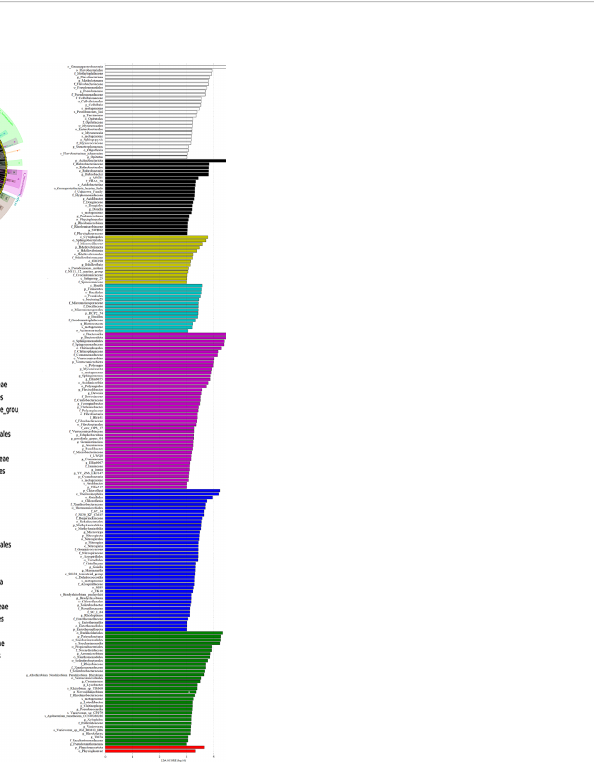
FIGURE 4 LEfSe analysis of soil bacterial community structure at different taxonomic levels among different rotation systems (LDA ≥ 3.0). The left fi gure is the cladogram of microbial communities. The right graph is the signi fi cant different taxa among treatments with LDA ≥ 3. B_51, O_51, PC_51 and PR_51 indicate the samples from B, O, PC and PR treatments at pre-planting, respectively; B_910, O_910, PC_910 and PR_910 indicate the samples from B, O, PC and PR treatments at